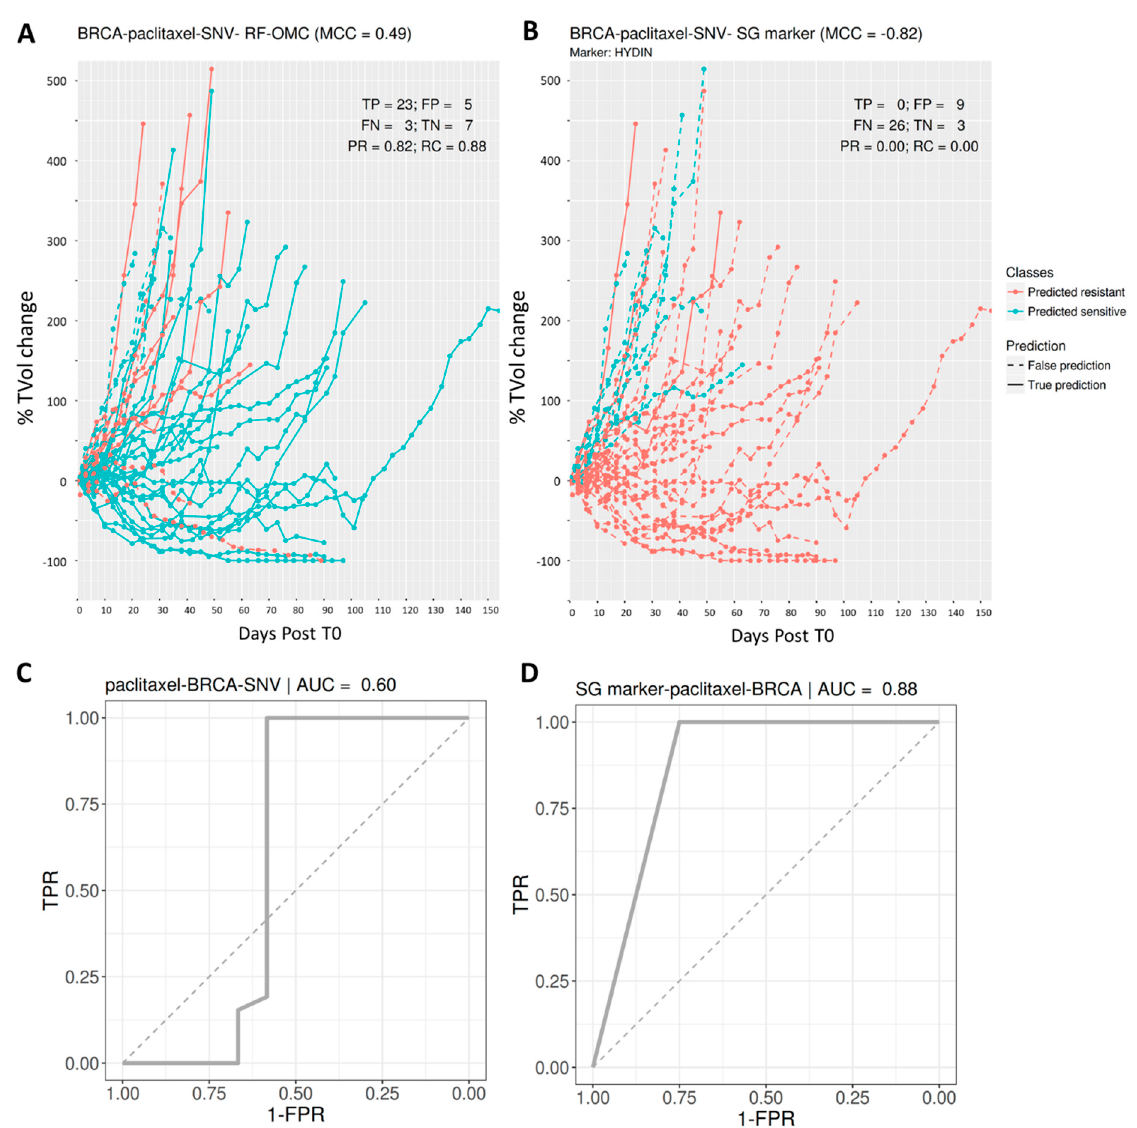
Figure 4. Predicting BRCA PDX response to the tubulin inhibitor paclitaxel. (Upper) Visualisation of tumour response prediction for test PDXs. ( A ) paclitaxel (2 fts) : RF-OMC predicts BRCA tumour response to paclitaxel by optimally combining the mutational states of two genes (MUC20 and UPK3BL). A high level of predictive accuracy was achieved on PDXs not used to train the model: MCC = 0.49 (PR = 0.82 and RC = 0.88). ( B ) paclitaxel (1 fts) : Using the same input data and evaluation protocol, the best single-gene marker of paclitaxel sensitivity was the mutational state of HYDIN. The RF-OMC model obtained a much higher level of prediction than that of this standard single-gene procedure: MCC = − 0.82 (PR = 0.00 and RC = 0.00). ( C , D ) ROC curves and their AUC values to compare the discrimination offered by both models across all possible operating thresholds. The corresponding AUC value was indicated on the top of the ROC curve. This alternative performance metric also assigns higher predictive performance to the multi-gene RF-OMC model.